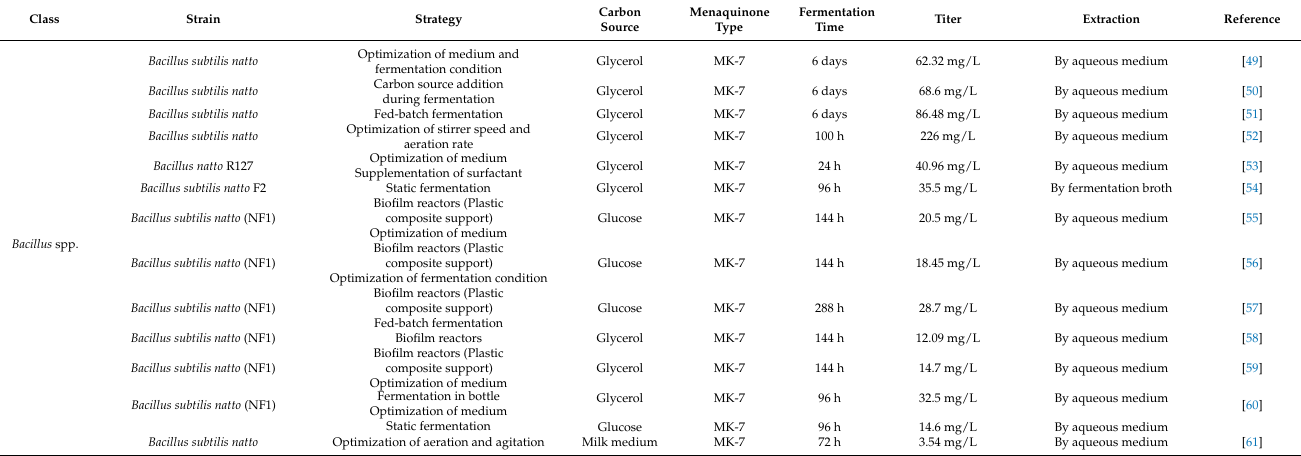
Table 1. Production of vitamin K2 using wild-type